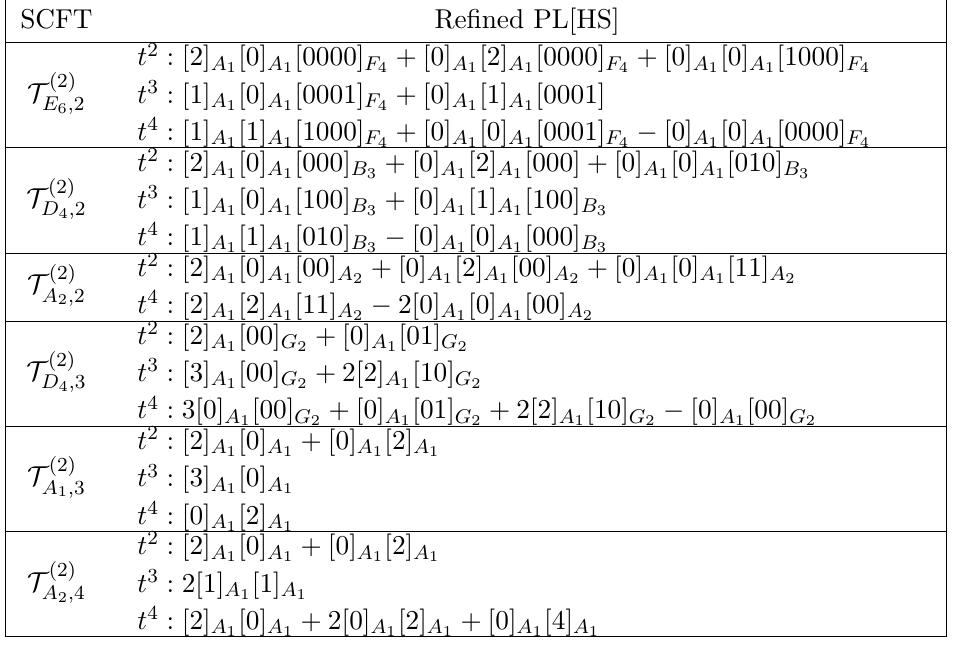
Table 6. Refined plethystic logarithm of the Hilbert series for the magnetic quivers of the T ( r =2) theories in table 2. In abuse of notation, [ . . . ] Dynkin labels [ . . . ]